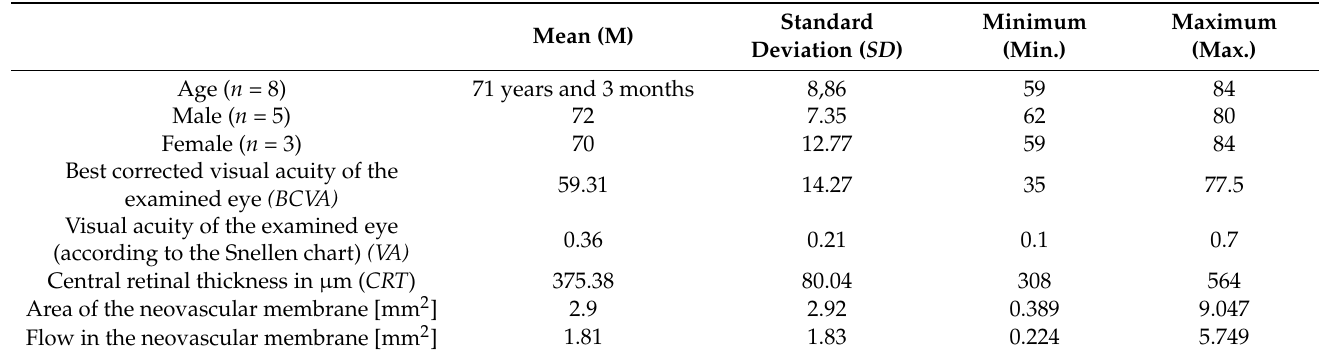
Standard Minimum Mean (M) Deviation ( SD ) (Min.)